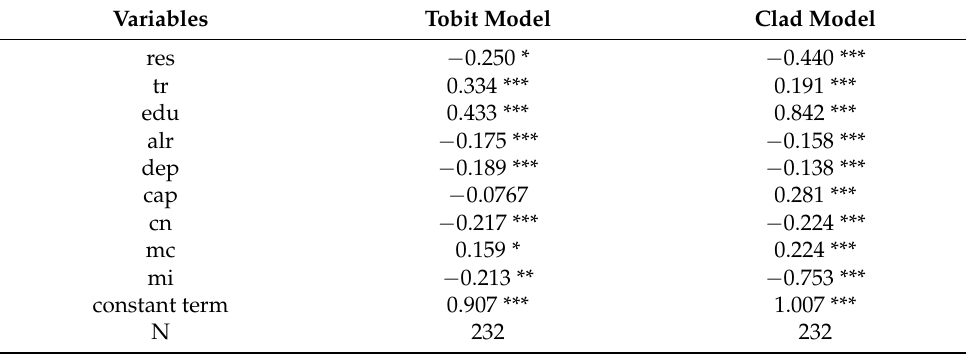
Table 7. Comparison of Tobit and Clad models and the regression results. Variables Tobit Model Clad Model res − 0.250 * − 0.440